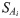
Predicted binding modes of disorder-to-order (DOR), context-dependent (CDR), disorder-to-disorder (DDR) and fuzzy regions.(A) Binding mode probabilities. The probabilities of disorder-to-disorder transitions are shown for DOR (blue), CDR (lime), DDR (salmon) and fuzzy (red) regions. The pDD values indicate significantly elevated disorder for interactions of DDRs and fuzzy regions as compared to DORs and CDRs. (B) Shannon entropy of binding modes. SAi values for DOR (blue), CDR (lime), and DDR (salmon) regions significantly differ between these binding modes. Context-dependent regions exhibit the highest binding mode diversity as compared to DORs and DDRs. Fuzzy, disordered binding regions (from the Fuzzy Complexes Database [25]) also have elevated SAi values indicating their context dependence. Statistical significances were determined by Mann-Whitney tests as implemented in the R program. p values as compared to CDRs are shown (** p < 10−2; *** p < 10−5).